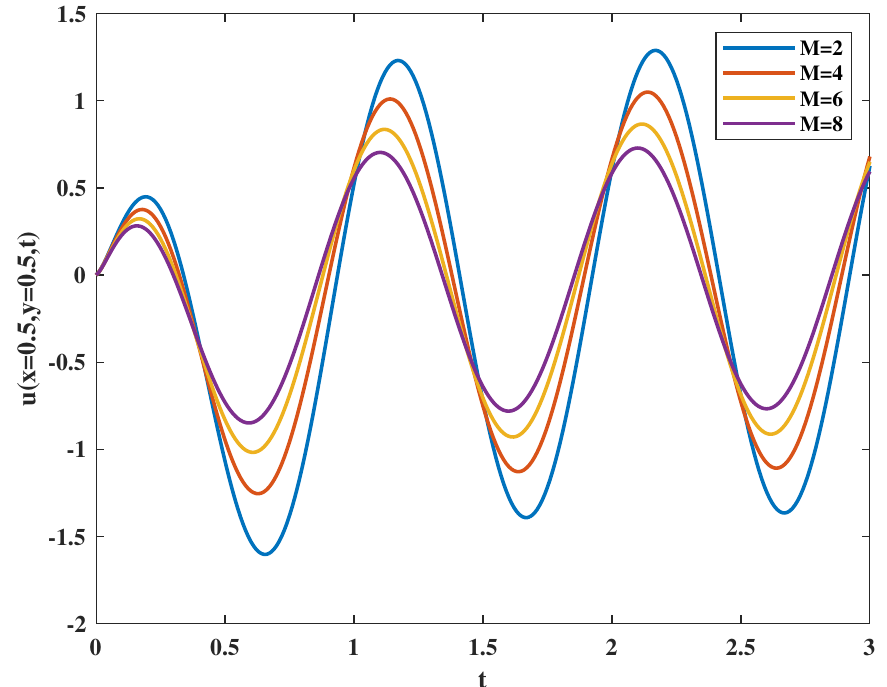
Figure 3. Velocity varies with magnetic parameter M .